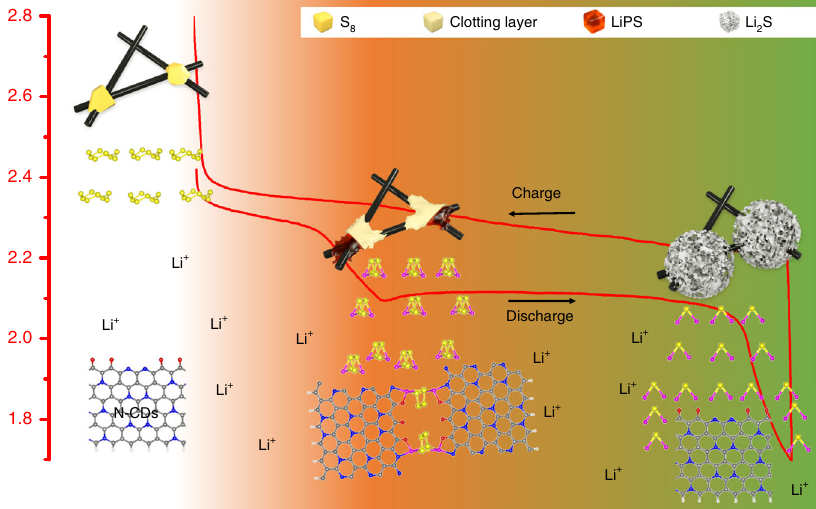
Fig. 8 Proposed LiPS clotting mechanism with N-doped carbon dots as the clotting factors of LiPS during the discharge/charge process. The morphology changes of sulfur particles on the surface of carbon fi bers as a function of discharge/charge status are depicted in the pro fi le curve. The interaction mechanisms between the N-CDs and LiPS at the interface of the sulfur cathode/electrolyte are portrayed in the lower portion of the fi